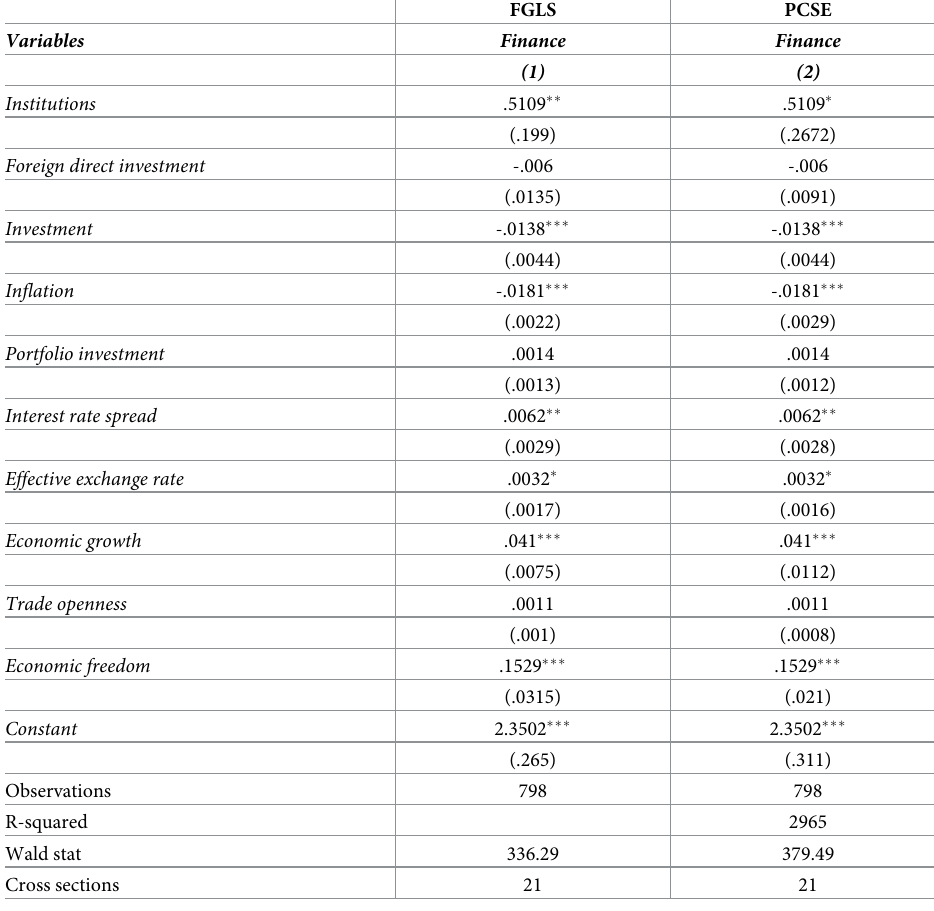
Table 10. Impact of institutions on finance–alternative estimators’